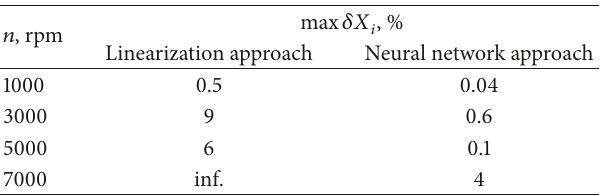
Table 1: Comparative results of rotor’s trajectory calculation at various rotation speed in 1000, . .. , 7000 rpm range.